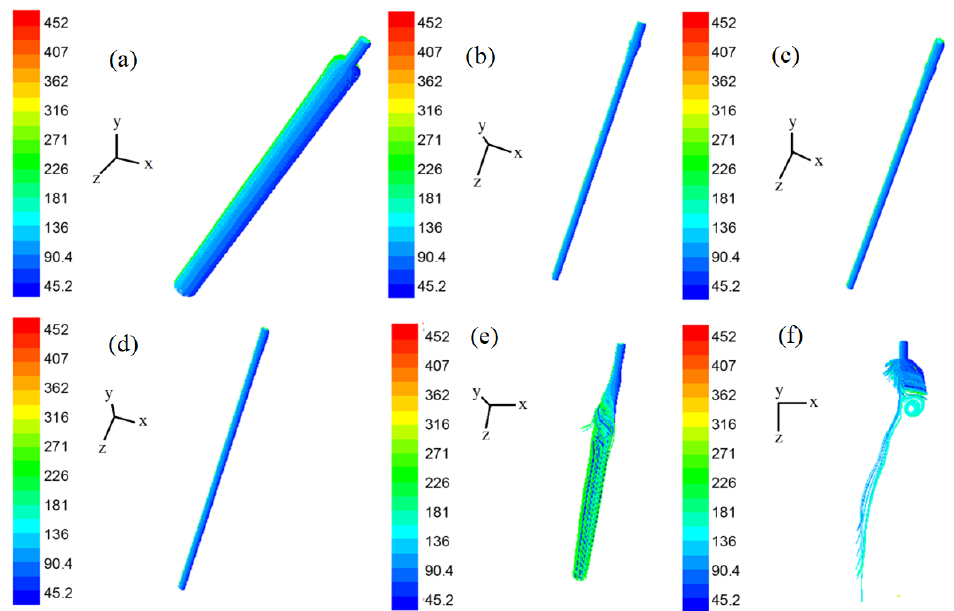
Figure 11. Pressure distribution on the y–z plane: ( a ) streamline diagram of the spinning line at t = 1.000 × 10 − 7 s; ( b ) streamline diagram of the spinning line at t = 1.600 × 10 − 6 s; ( c ) streamline diagram of the spinning line at t = 2.979 × 10 −5 s; ( d ) streamline diagram of the spinning line at t = 1.338 × 10 −4 s; ( e ) streamline diagram of the spinning line at t = 6.013 × 10 − 3 s; ( f ) streamline diagram of the spinning line at t = 1.543 × 10 − 2 s.